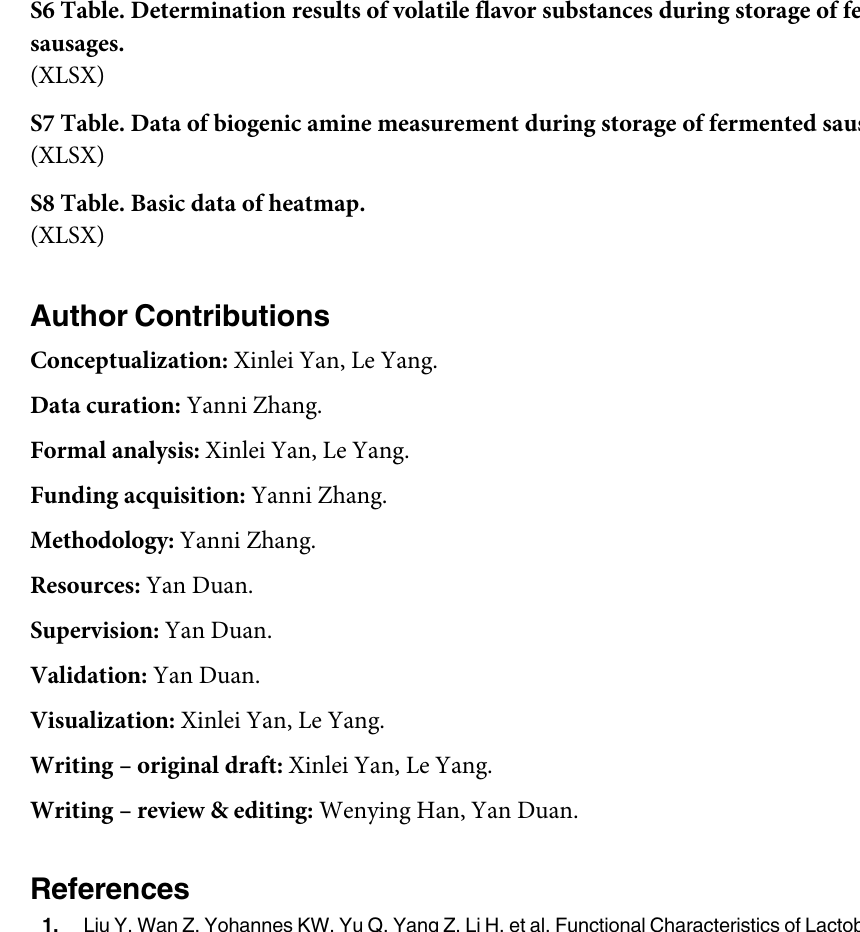
S1 Table. Data of color measurement during processing and storage of fermented sau- sages. S2 Table. Data of water activity measurement during processing and storage of fermented sausages. S3 Table. Data of pH during processing and storage of fermented sausages. S4 Table. Data of microbiological indicators during processing and storage of fermented sausages. S5 Table. Data of TPA measurement during storage of fermented sausages. S6 Table. Determination results of volatile flavor substances during storage of fermented sausages. S7 Table. Data of biogenic amine measurement during storage of fermented sausages. (XLSX) S8 Table. Basic data of heatmap.